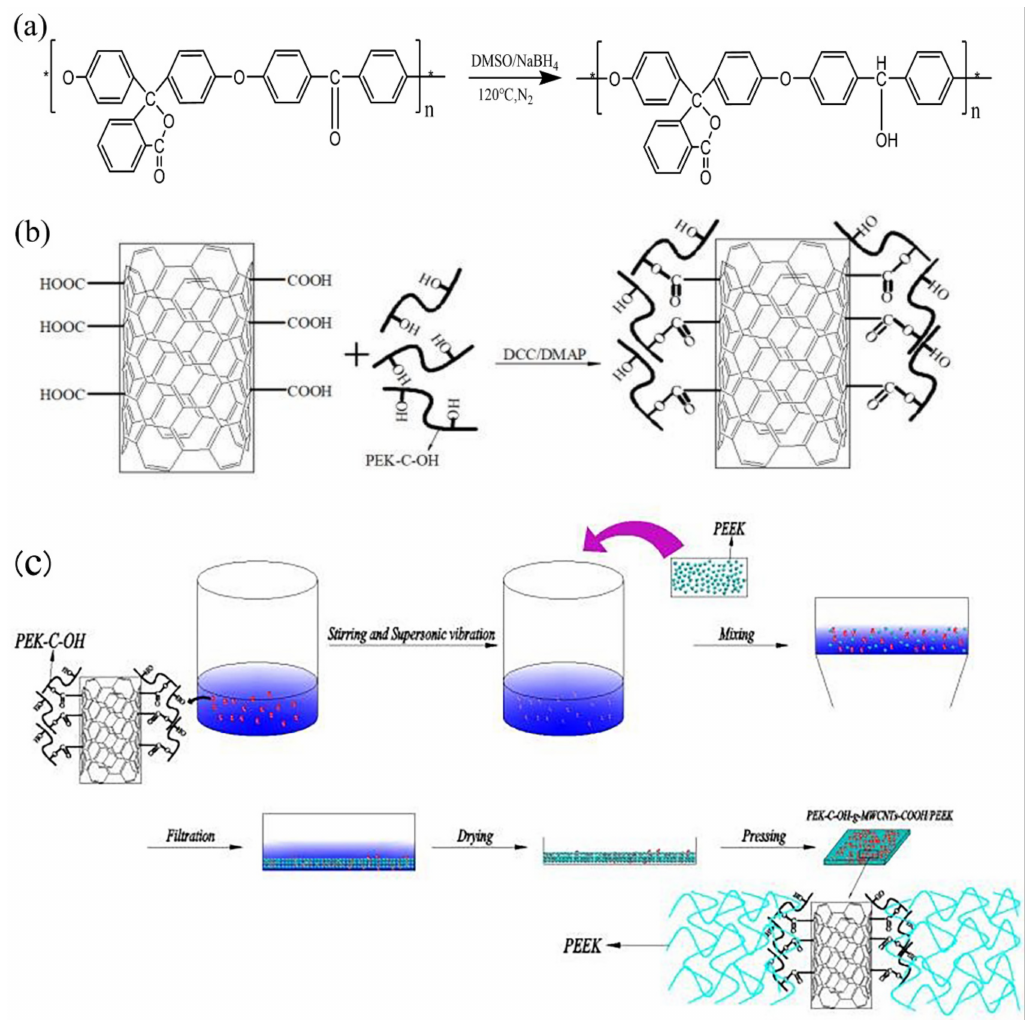
Figure 1. ( a ) Synthesis of PEK-C-OH; ( b ) Synthesis of PEK-C-OH-g-MWCNTs-COOH; ( c ) The preparation process of MWCNTs-COOH-g-PEK-C-OH/PEEK